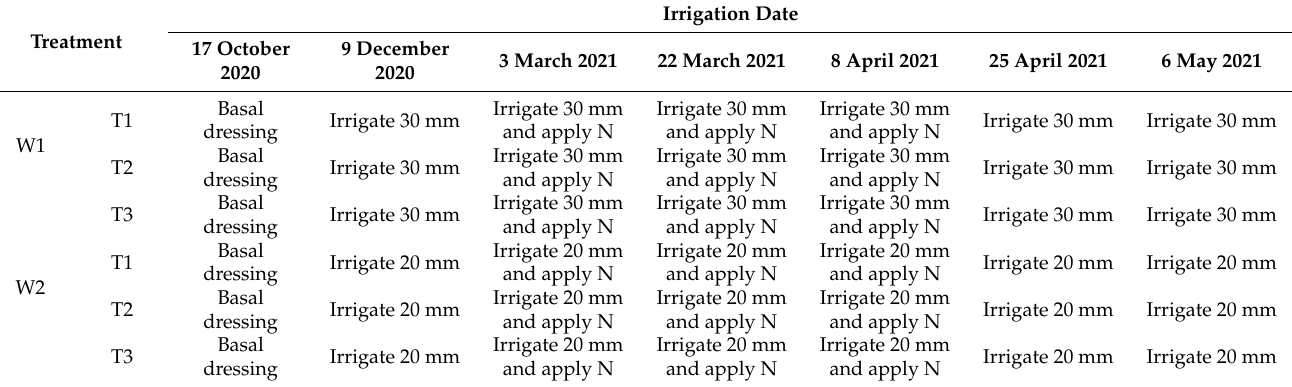
Table 1. Irrigation and fertilization scheduling during winter wheat season in 2020 – 2021.